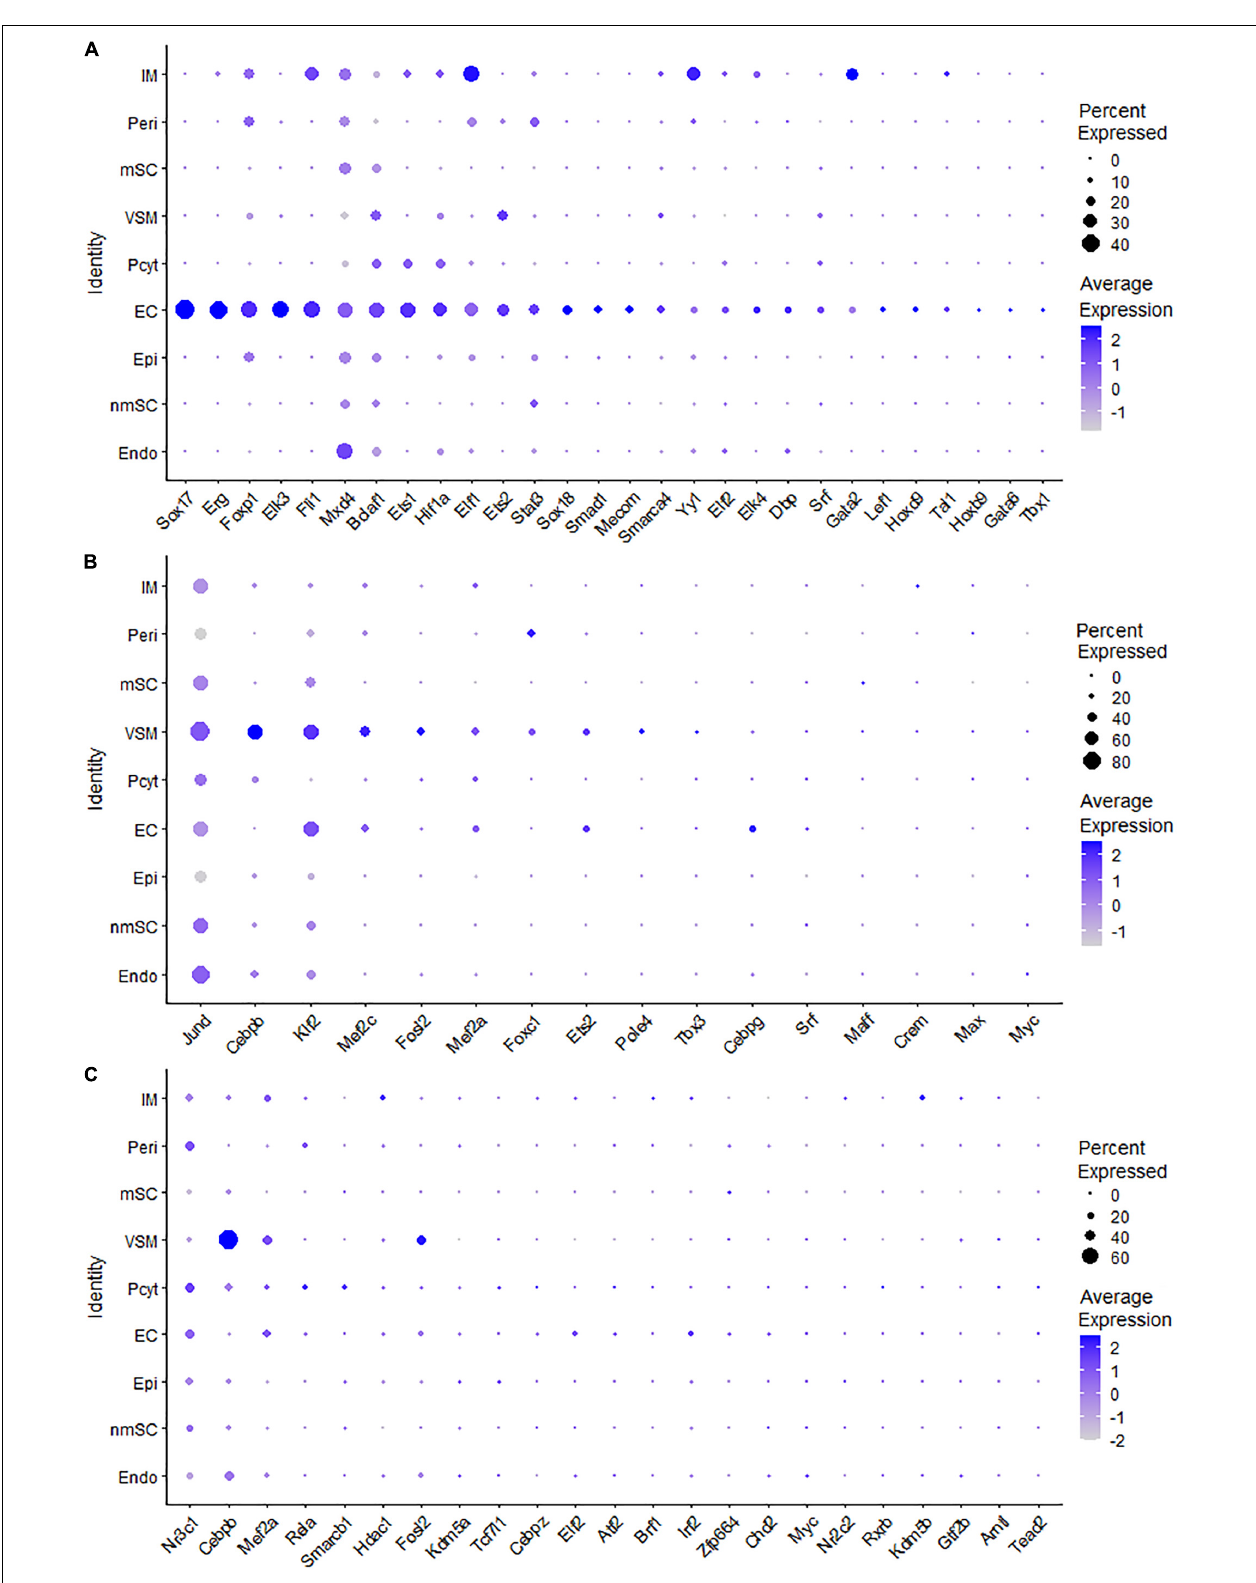
FIGURE 8 | TF expression in ECs, VSM cells, and pericytes. (A) Twenty-eight identified TFs in ECs expressed in more than 5% of ECs. (B) Sixteen identified TFs in VSM cells expressed in more than 5% of VSM cells. (C) Twenty-three identified TFs in pericytes expressed in more than 5% of pericyte cells.